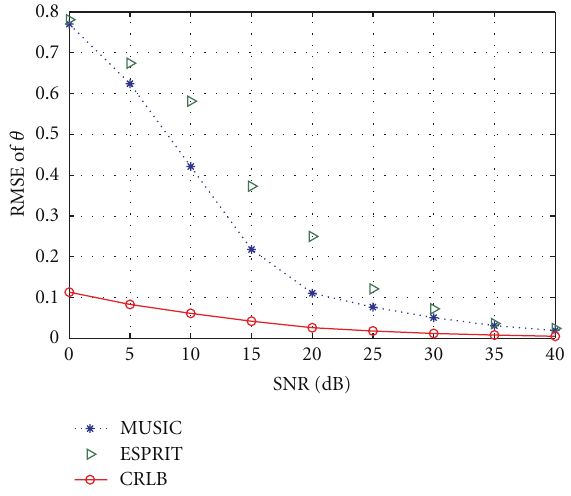
Figure 15: Performance comparison for the estimation of elevation angle using MUSIC and ESPRIT algorithms using CCRA design of case (d).